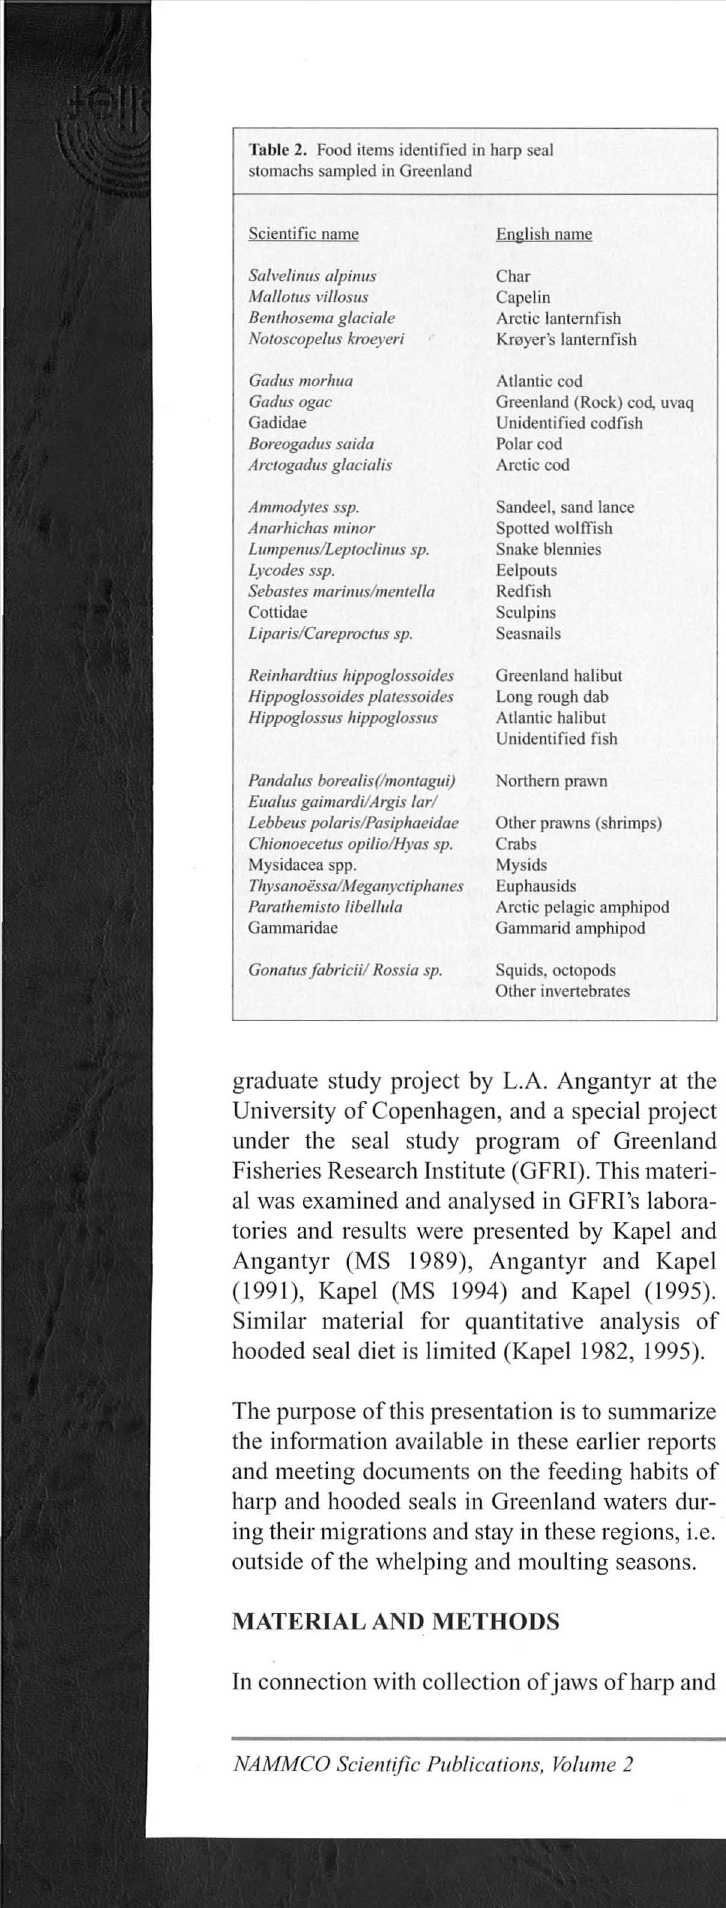
Table 2. Food items identified in harp seal stomachs sampled in